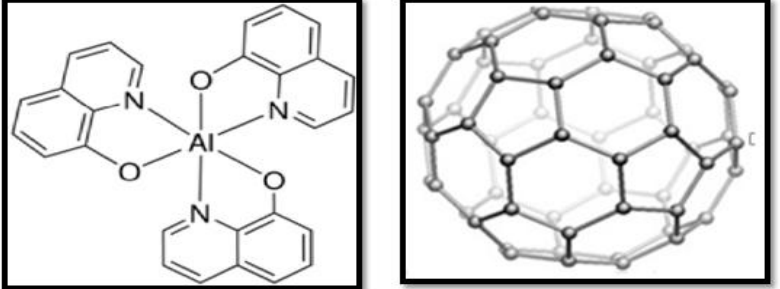
Fig. 1: Chemical structure of (a) Tris-(8-hydroxyquinoline) aluminum (Alq